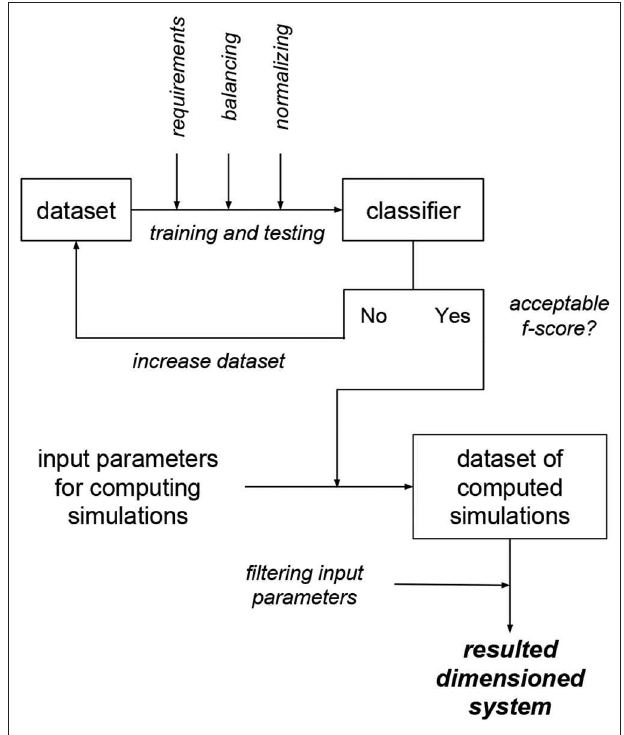
FIGURE 8 | Scheme for the procedure to dimension magnetocaloric systems with statistical learning